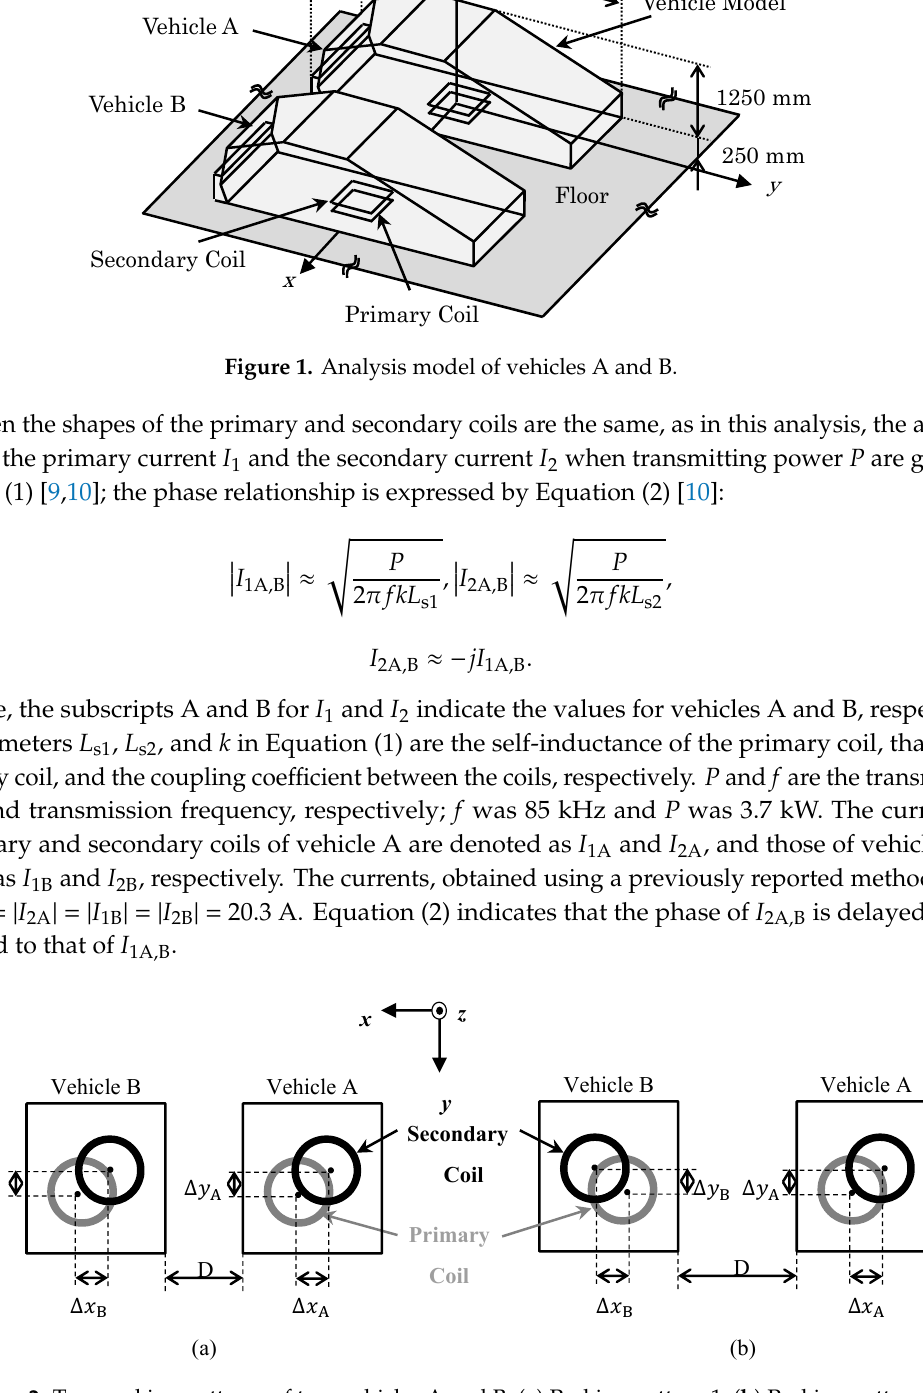
Figure 2. Two parking patterns of two vehicles A and B: ( a ) Parking pattern 1; ( b ) Parking pattern 2.